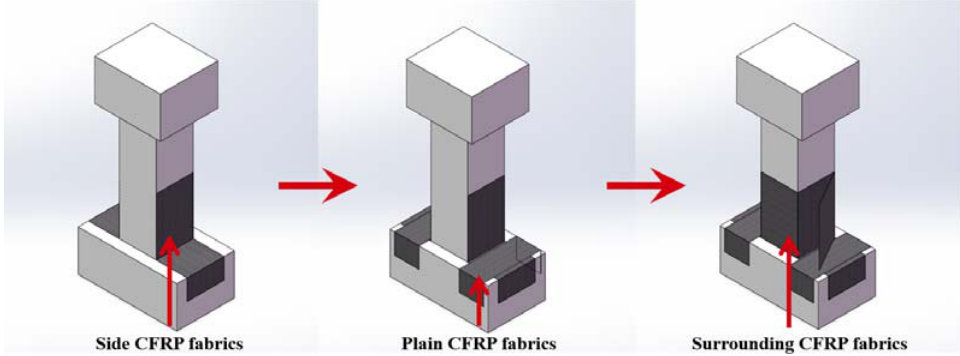
Figure 3. Repair design for the damaged precast column with CFRP fabrics.